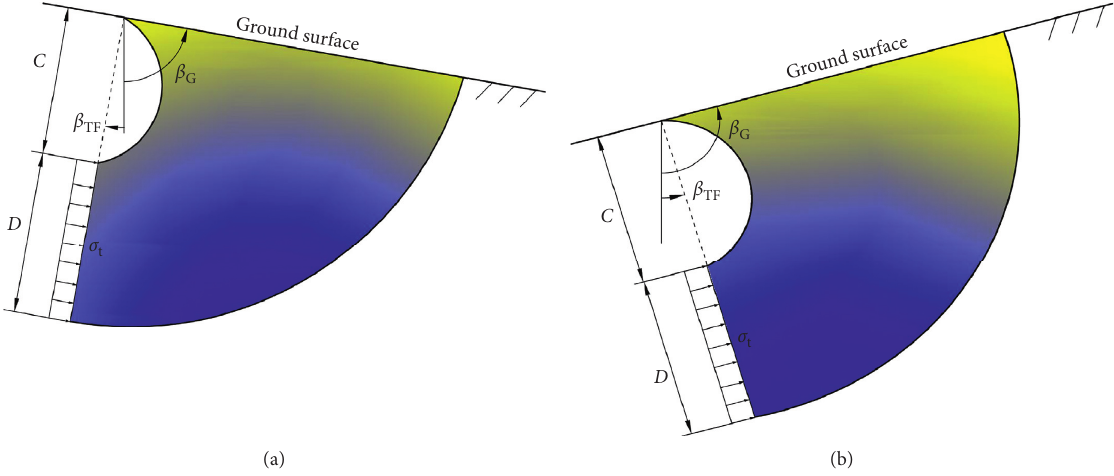
Figure 1: Tunneling with a longitudinal gradient in (a) downward movement; (b) upward